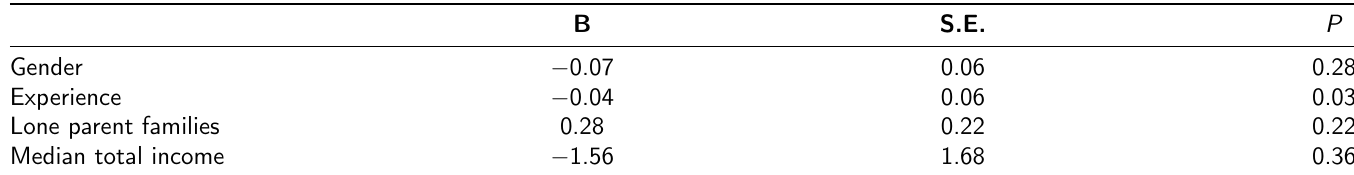
Table 7: Results of the poisson regression analysis examining the percent of lone parent families, median neighbourhood income, and total educator-reported concerns for returning to school (N =